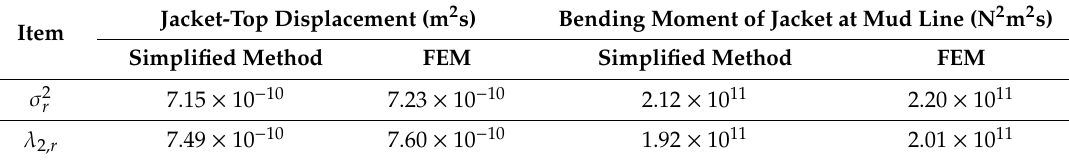
Figure 4. Results for ( a ) PSD of jacket-top displacement and ( b ) bending moment of the jacket at the mud line. Table 3. Several spectral moments.